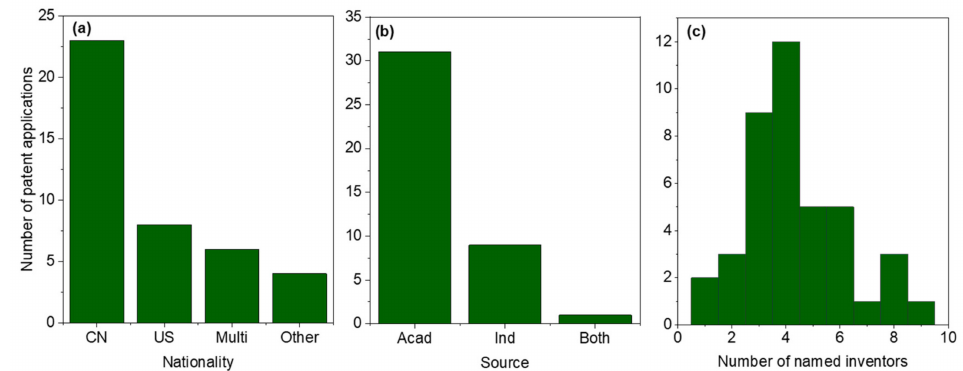
Figure 2. Further analysis of DNA origami patent applications. ( a ) Nationality of inventors. Taken directly from patents where given. Where inventor nationality was not given, the nationality of the originating institution was used instead. CN = China, US = United States, Multi = more than one nationality involved (all but one of these teams were partly American). ( b ) Type of